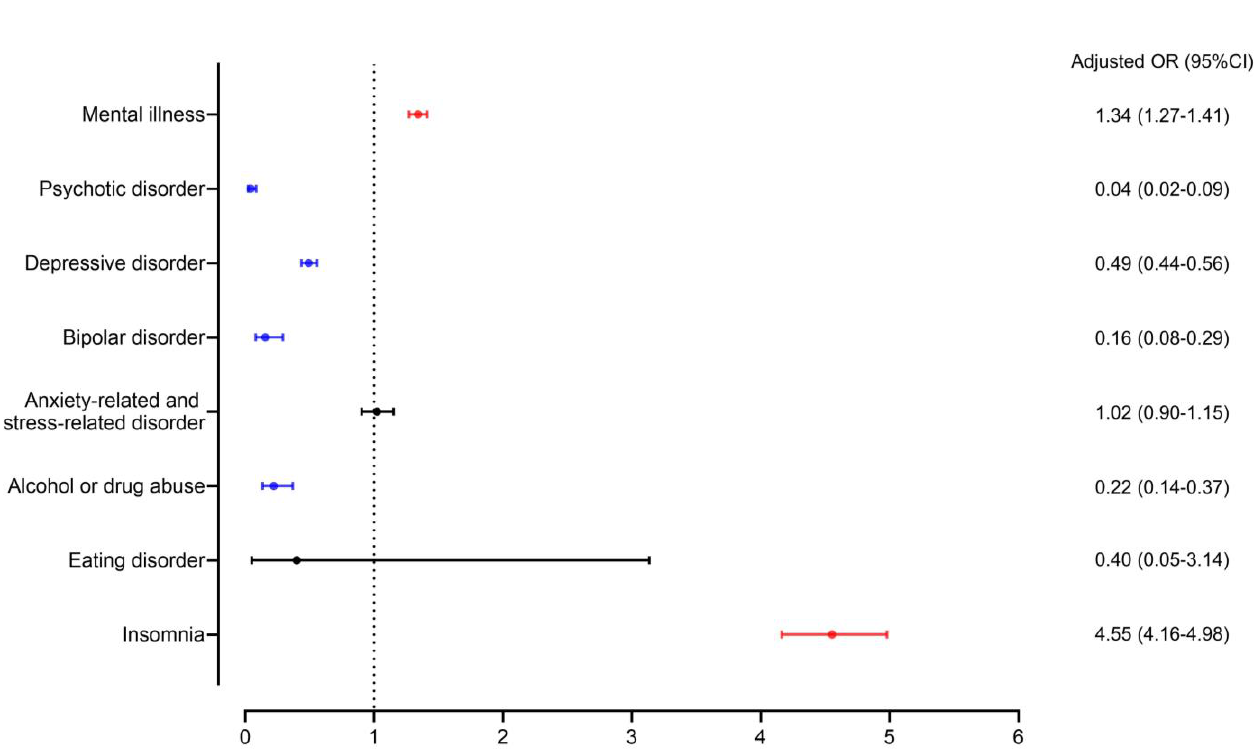
Figure 2. The distribution of mental illnesses in the hemifacial spasm group and the control group .